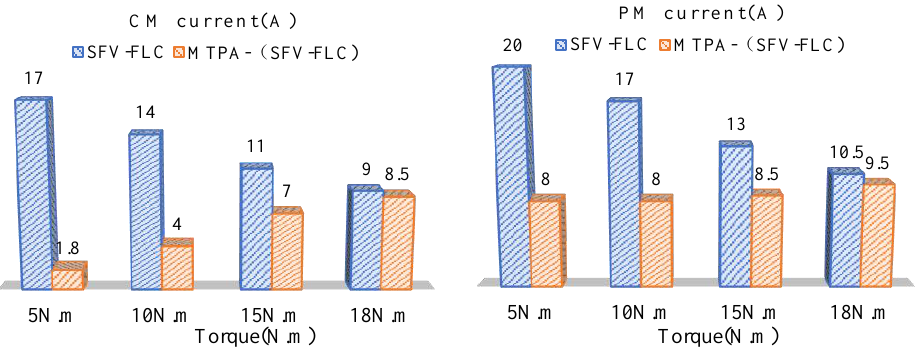
Figure 10. Simulation experiment data when the torque changes.